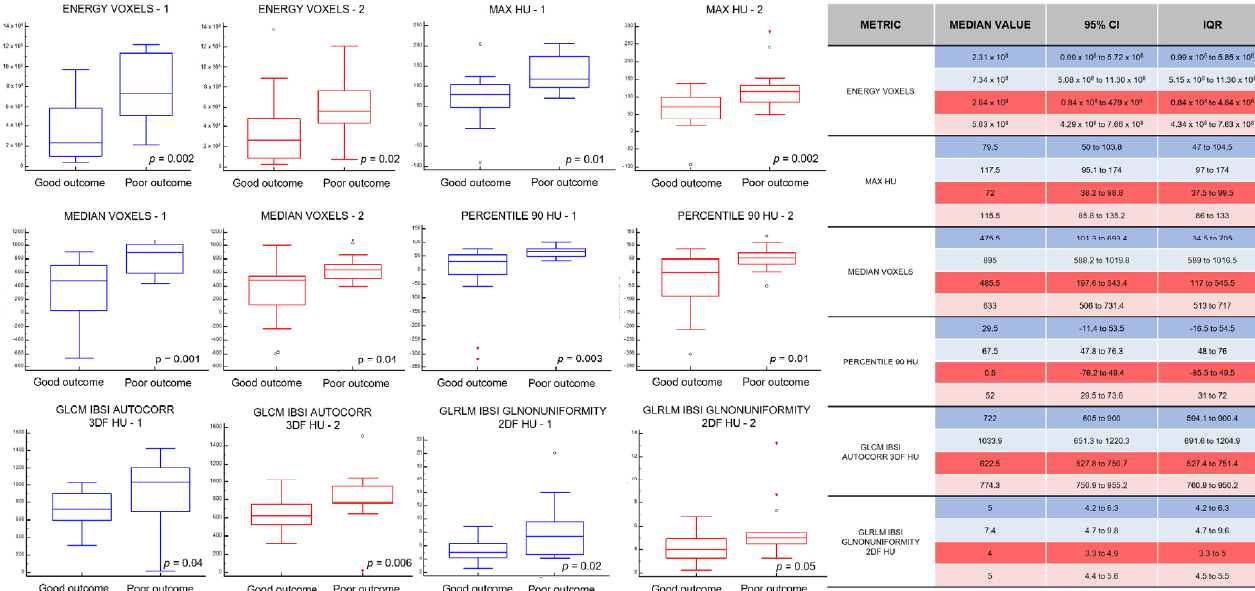
Figure 4. Description of selected features. On the left, the box plots for each selected feature. In the box plot, the central box represents the values from the lower to upper quartile (25 to 75 percentile). The middle line represents the median. The vertical line extends from the minimum to the maximum value, excluding outside and far out values which are displayed as separate points (respectively, marked as black circles and red triangles). The blue box plots represent the results obtained with the segmentation and feature extraction performed by the first radiologist. The red box plots display the results obtained by a second radiologist. On the right, the median value of the box plots, the 95% (CI), and the (IQR) values for each relevant feature are reported in the table. The results are differentiated by different colors: blue and red colors indicate, respectively, the first and the second radiologists, while, for each group, the first row represents patients with a long survival (good outcome) and the second row represents patients with short survival (poor outcome). Feature acronyms: ENERGY VOXELS = IBSI-consistent intensity-based energy that represents a measure of the magnitude of raw voxel values, MAX HU = IBSI-consistent maximum of the Hounsfield Unit values, MEDIAN VOXELS = IBSI-consistent median of the raw voxel values, PERCENTILE 90 HU = IBSI-consistent lowest intensity that is greater than 90% of the voxel intensities (expressed in Hounsfield Unit), GLCM IBSI AUTOCORR 3DF HU = IBSI-consistent Autocorrelation measured on the Gray Level Co-occurrence Matrix and computed from each 3D directional matrix and averaged over the 3D direc- tions (expressed in Hounsfield Unit), GLRLM IBSI GLNONUNIFORMITY 2DF HU = IBSI-consistent Gray level non-uniformity measured on the Gray Level Run Length Matrix and computed from each 2D directional matrix and averaged over 2D directions and slices (expressed in Hounsfield